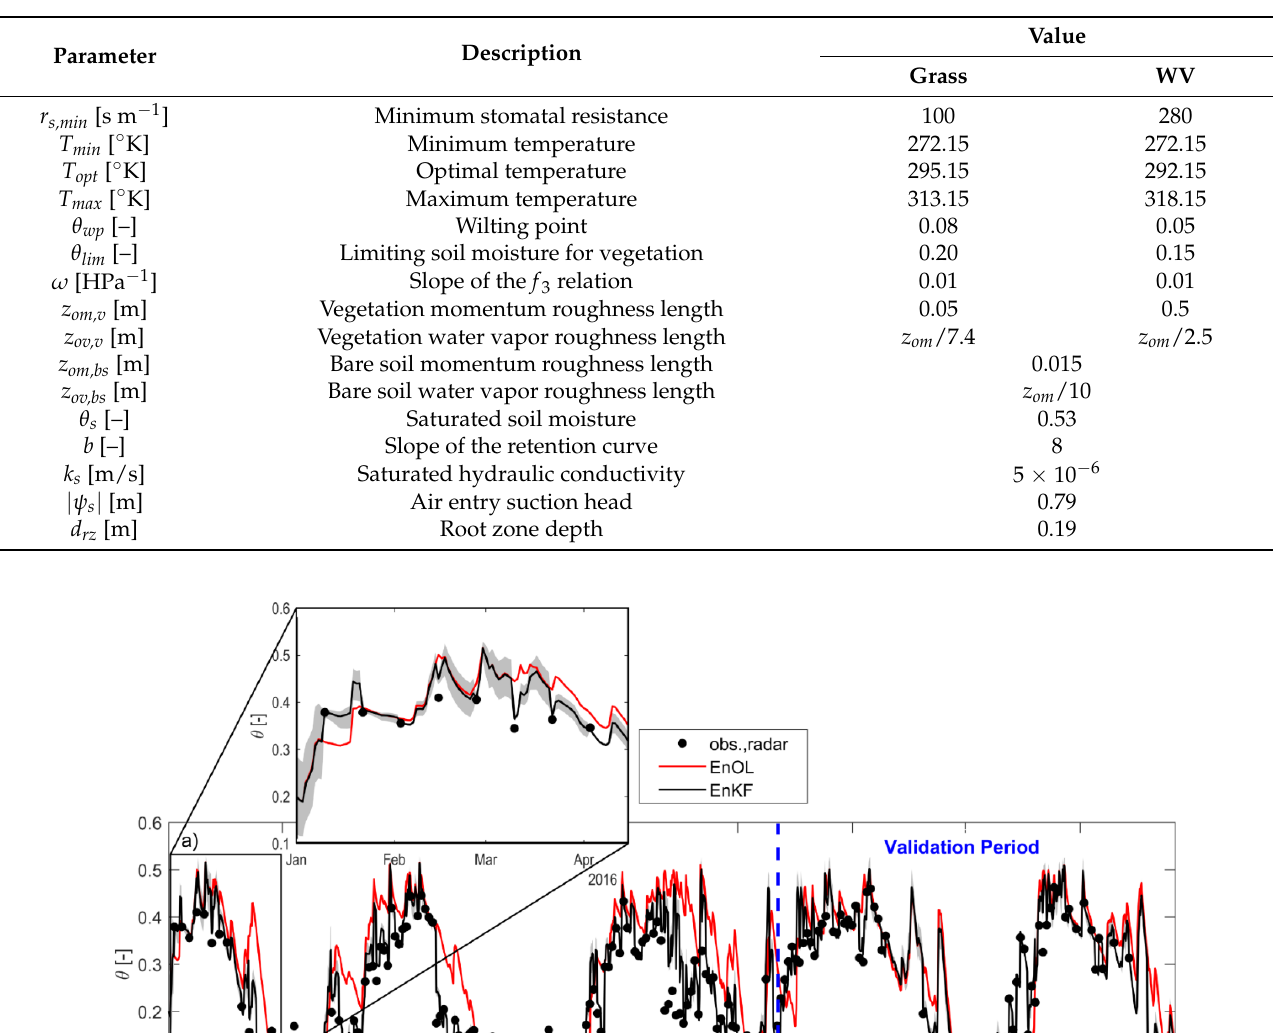
Table 2. Land surface model parameters for the Orroli site.